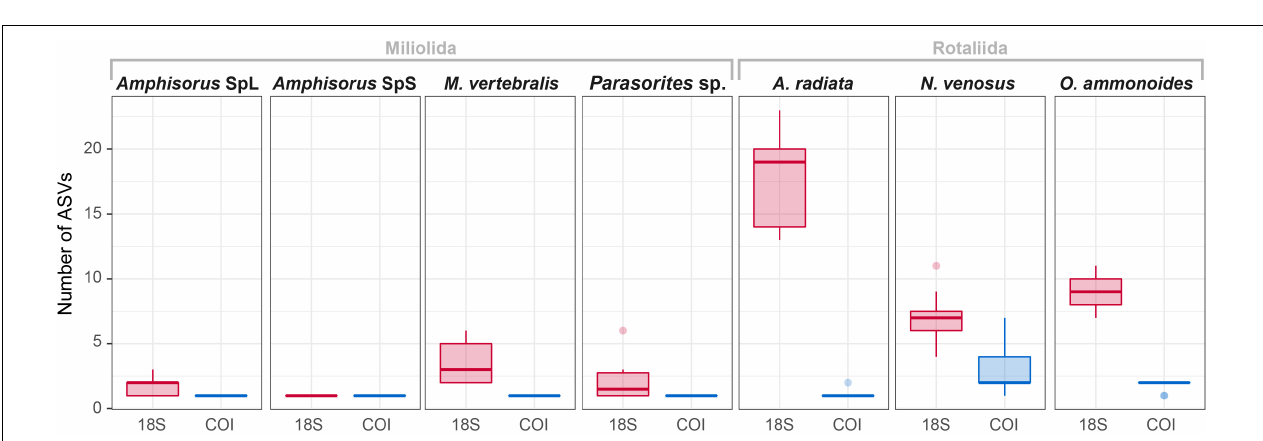
FIGURE 3 | Overview of the number of ASVs in each specimen for 18S and COI